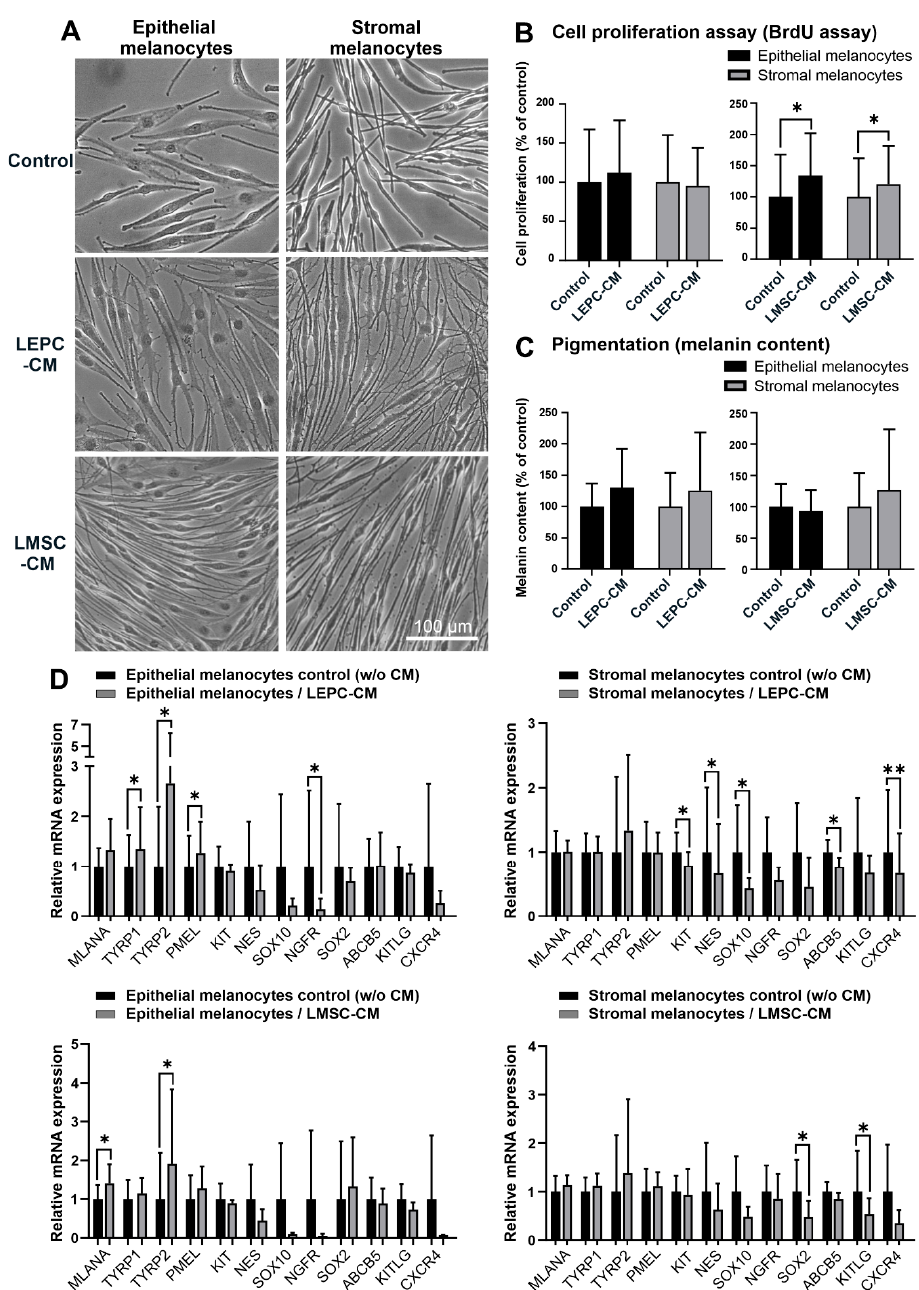
Figure 6. Effects of soluble factors on limbal epithelial and stromal melanocytes. ( A ). Phase-contrast images of limbal epithelial and stromal melanocytes cultured in conditioned media derived from limbal epithelial stem/progenitor cells (LEPC-CM) and limbal mesenchymal stem cells (LMSC-CM) (the magnification bar at the bottom-right corner applies to all images). ( B ). The effect of LEPC-CM